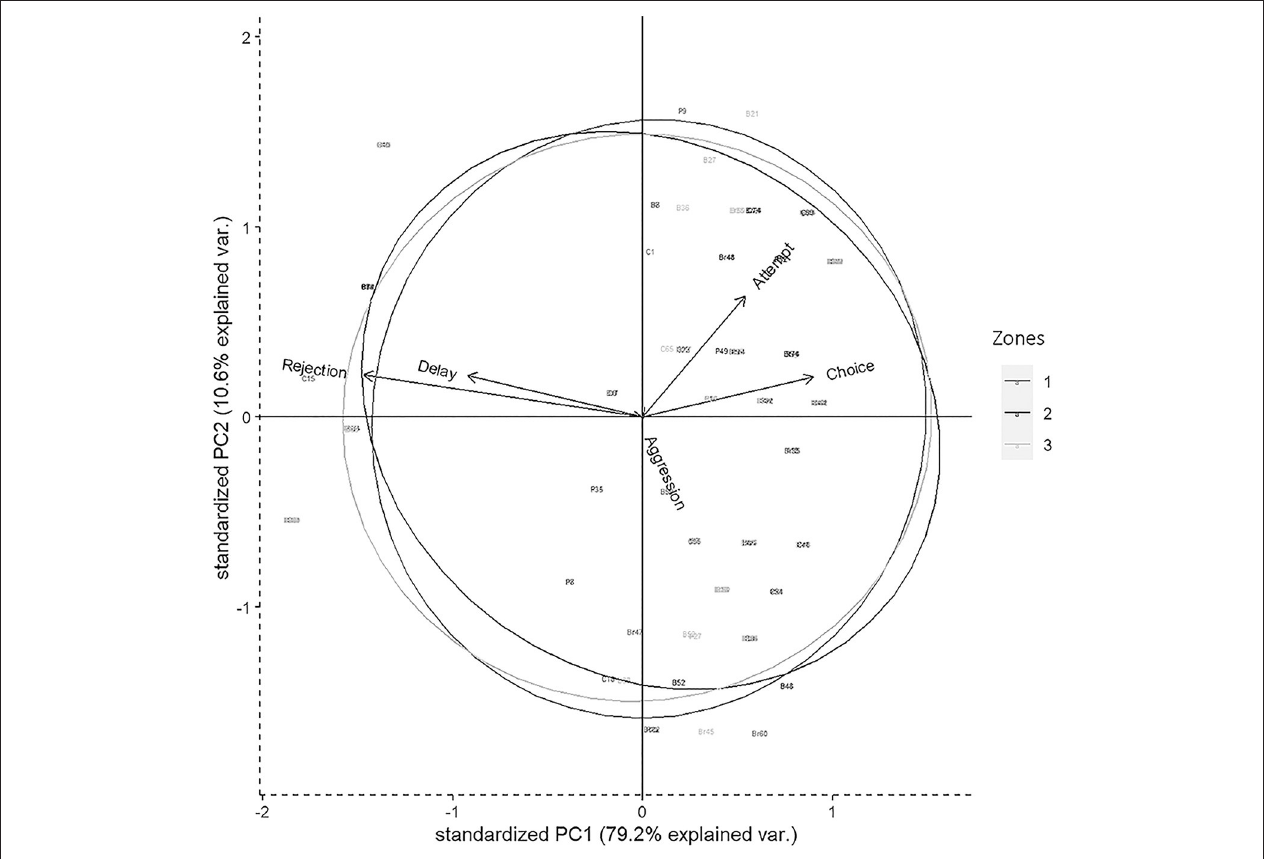
FIGURE 2 | Biplot representing the distribution of variables in 2D space for the Principal component analysis (PCA) having descriptors like attempt, choice, delay, rejection, and aggression. Circles represent three different zones of